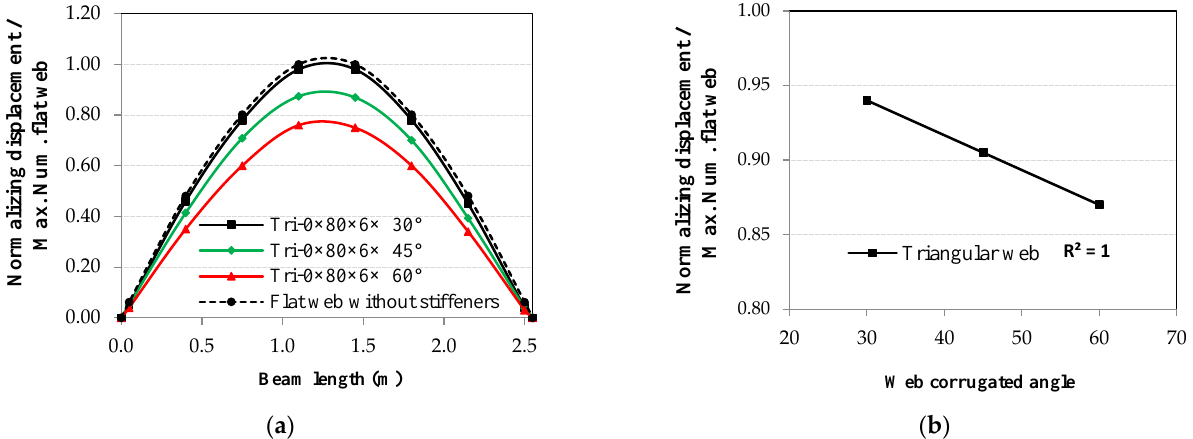
Figure 18. Corrugated angle effect on the relationship between normalized displacement and beam length for the 1st mode shape: ( a ) triangular web and ( b ) angle effect at the 1st mode shape.